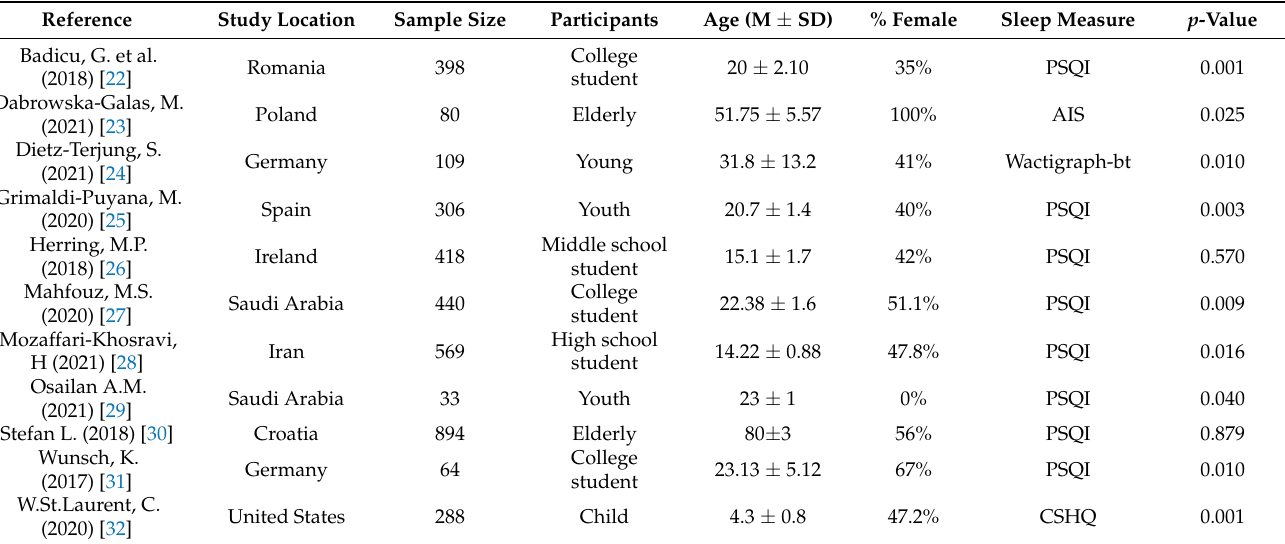
Table 2. Characteristics of literature included in this study.